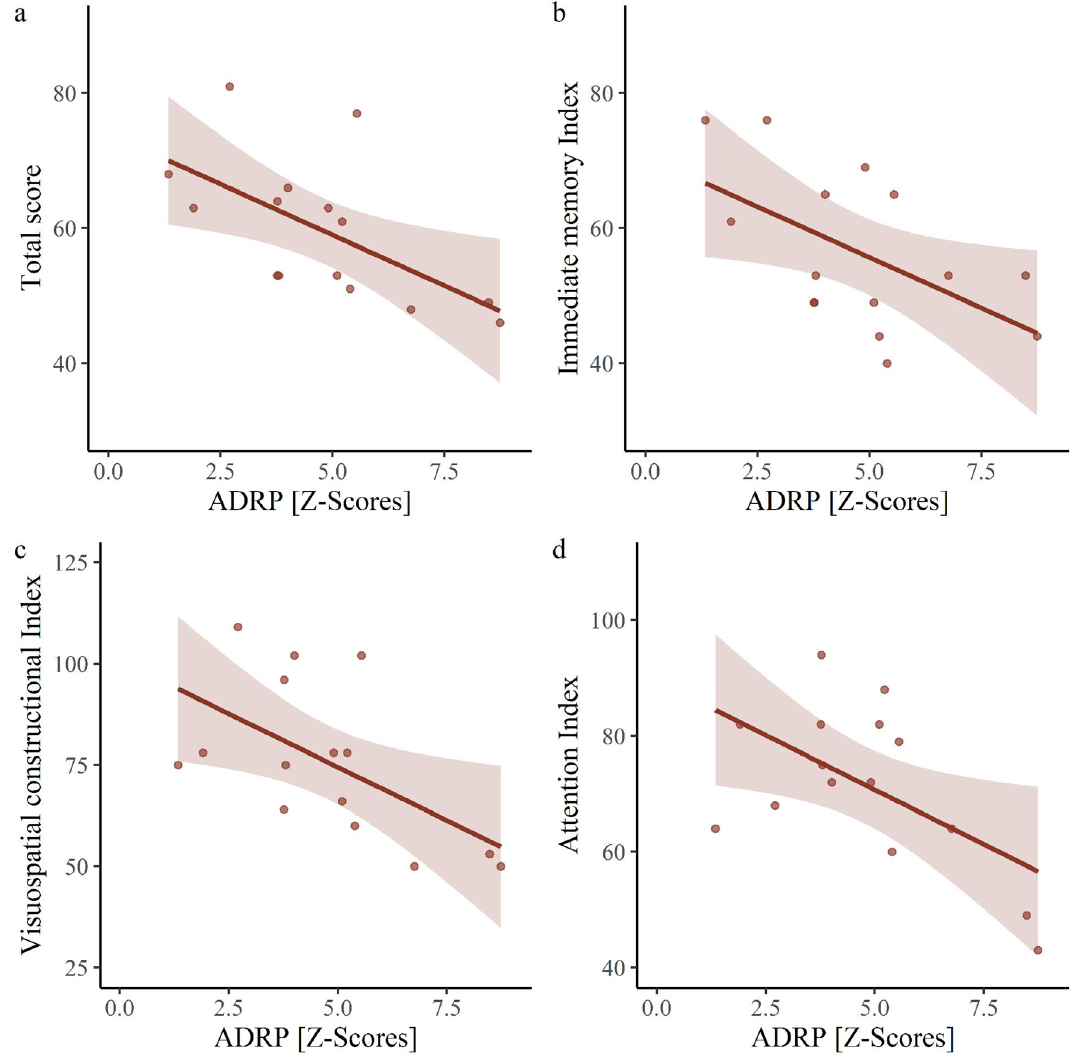
Figure 6. Correlations between Alzheimer’s disease-related pattern expression and neuropsychological tests in internal validation Alzheimer’s dementia cohort. Each dot represents an individual patient’s data and the lines and shaded areas correspond to the fit of a linear regression with 95% confidence intervals. ( a ) ADRP expression correlated with RBANS Total score (r = −0.60), ( b ) Immediate Memory Index (r = −0.55), ( c ) Visuospatial Constructional Index (r = − 0.58) and ( d ) Attention Index (r = −0.57). ADRP Alzheimer’s disease-related pattern, RBANS Repeatable Battery for the Assessment of Neuropsychological